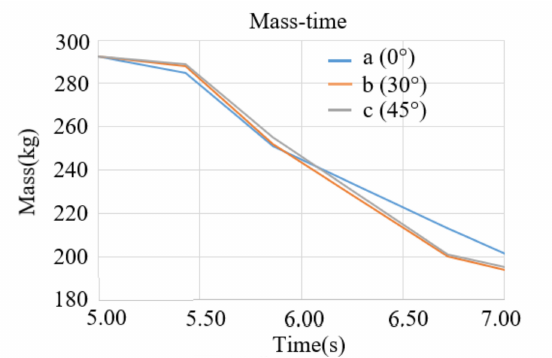
Table 9. The change of soil ridge quality with different direction angles of the duct mouth. The Direction Angle of the Initial Mass of Soil Ridge Mass Soil Ridge Mass Soil Ridge Mass Soil Ridge Mass Duct Mouth Soil Ridge/(kg) at 0.43 s/(kg) at 0.86 s/(kg) at 1.72 s/(kg) at 2 s/(kg) 0 ◦ 292.3 285.0 251.0 213.0 30 ◦